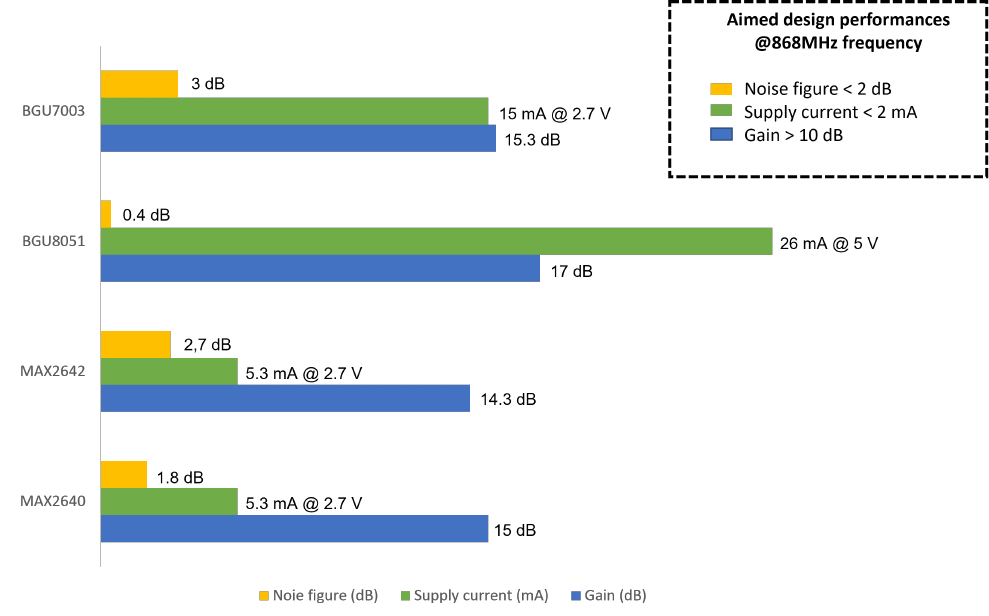
Figure 3. Identification of design requirements based on selected commercialized off-the-shelf LNA performance at 868